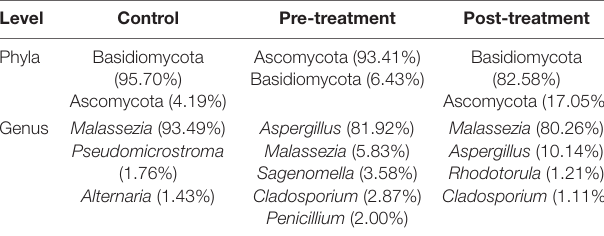
TABLE 4 | Main taxonomic composition ( > 1% and the top five) of fungal communities in three